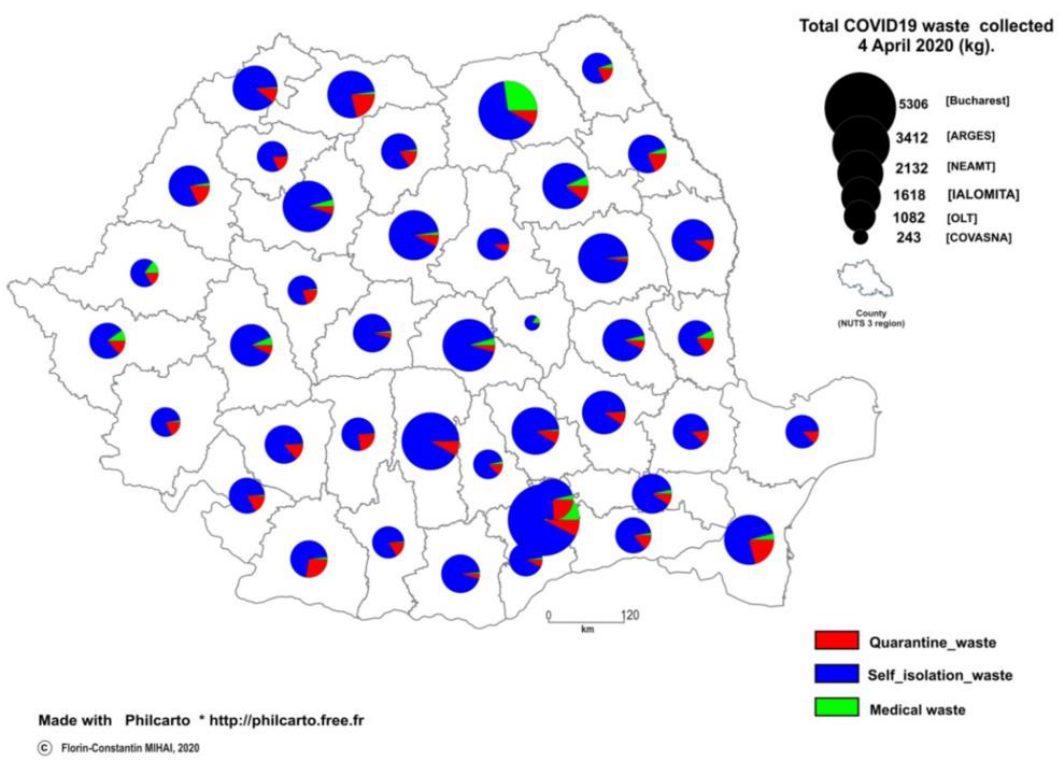
Figure 3. Regional disparities in COVID19-related waste flows as of 4 April 2020 (emergency state) Counties info: https://en.wikipedia.org/wiki/Counties_of_Romania.